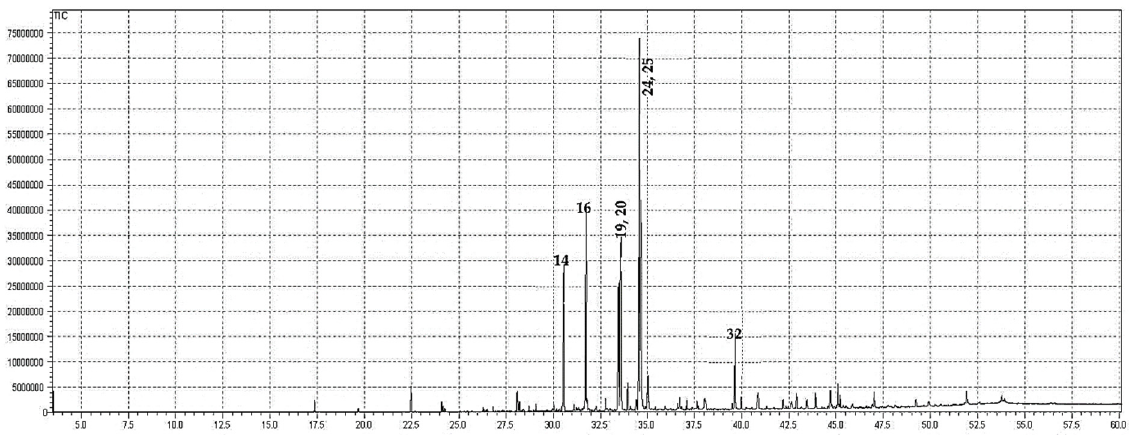
Figure 1. GC chromatogram of the oils of S. edelbergii.